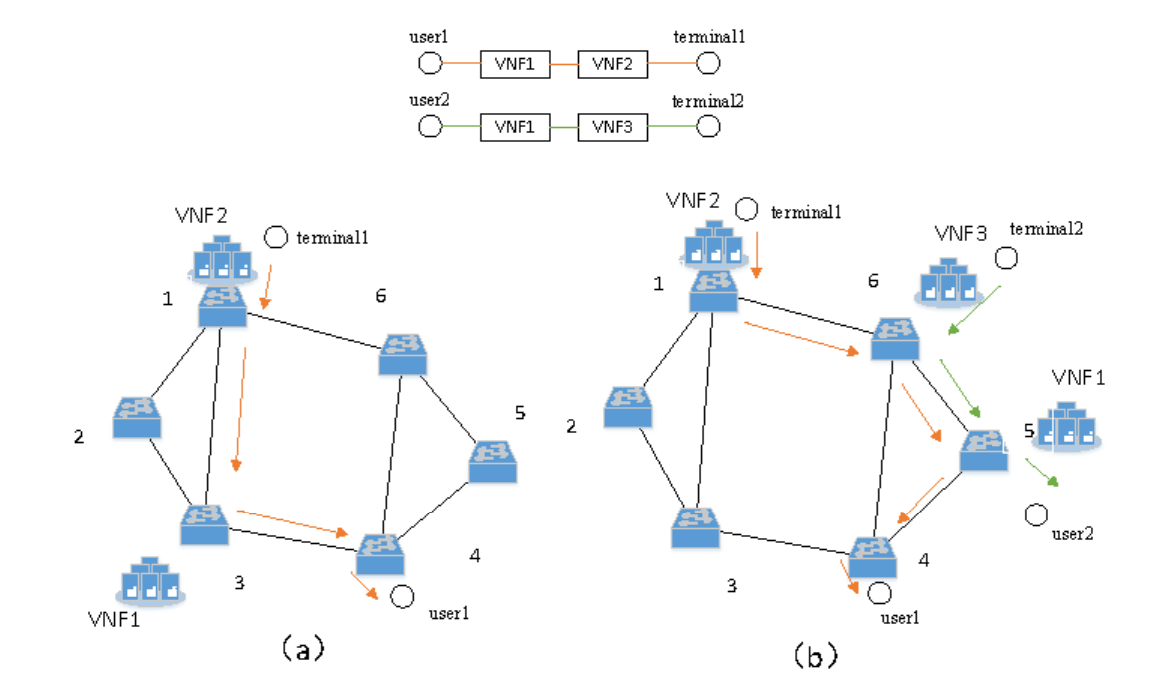
Figure 1. Dynamic deployment of SFC. ( a ) One user is connected to the network; ( b ) Another user is also connected to the network. Table 1. The time consumed by different VM operations